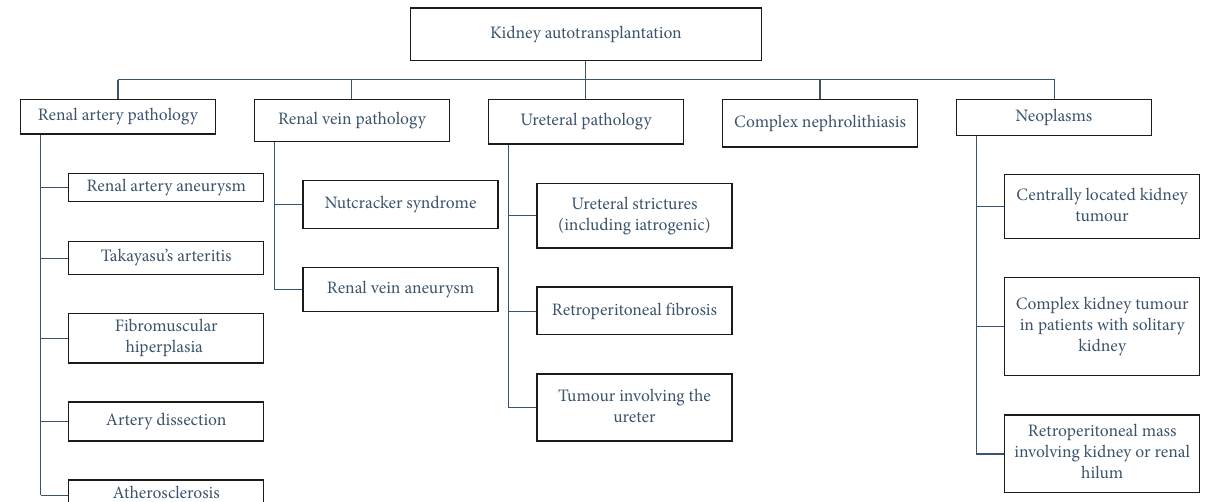
Figure 2: Indications for kidney autotransplantation